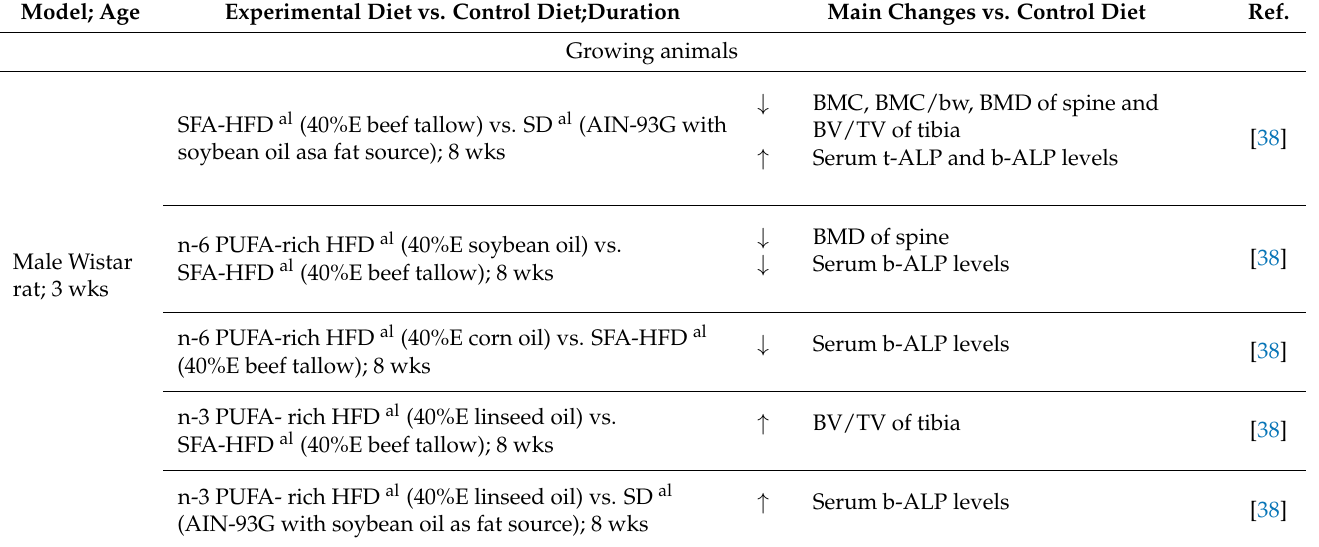
Table 1. Studies in animal models investigating the role of high-fat diet on bone tissue. Model; Age Experimental Diet vs. Control Diet;Duration Main Changes vs. Control Diet Ref. Growing